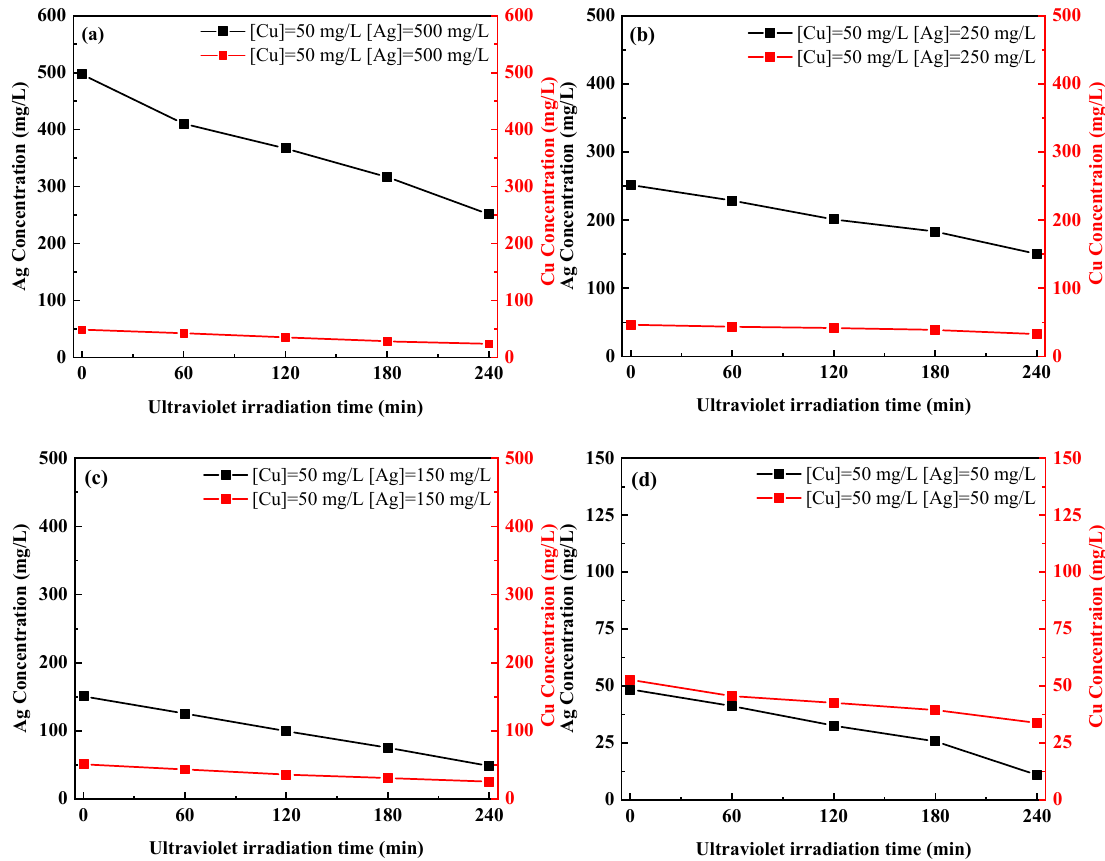
Figure 9. The separation of Ag and Cu from their aqueous thiosulfate complex. ( a ) First time: [Ag] = 500 mg/L, [Cu] = 50 mg/L, [S 2 O 32 − ] = 0.1 mol/L, 298 K, uncontrolled pH; ( b ) second time: [Ag] = 250 mg/L, [Cu] = 50 mg/L, [S 2 O 32 − ] = 0.1 mol/L, 298 K, uncontrolled pH; ( c ) third time: [Ag] = 150 mg/L, [Cu] = 50 mg/L, [S 2 O 3 2 − ] = 0.1 mol/L, 298 K, uncontrolled pH; ( d ) fourth time: [Ag] = 50 mg/L, [Cu] = 50 mg/L, [S 2 O 32 − ] = 0.1 mol/L, 298 K, uncontrolled pH.